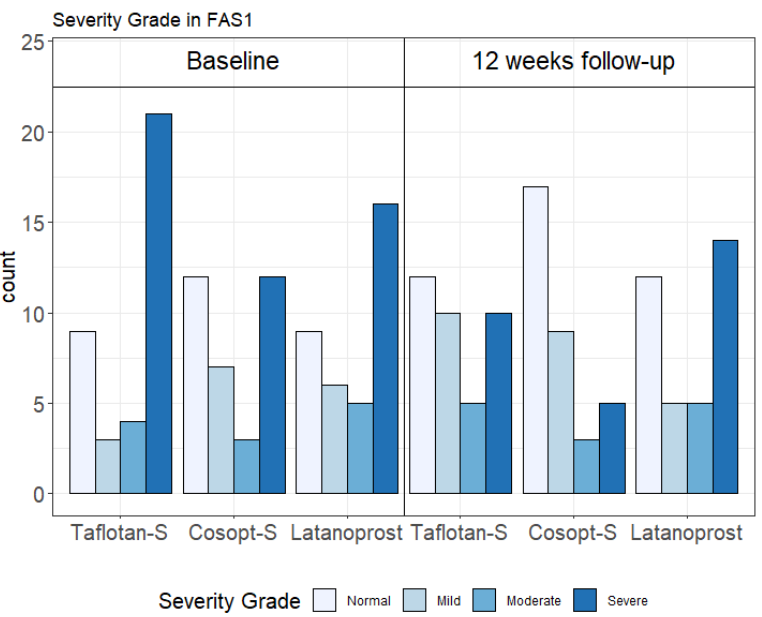
Figure 1. Ocular surface disease index (OSDI) severity categories in each treatment arm at baseline and 12-week follow-up in the Full Analysis Set 1 (FAS1) population ( n = 107). Taflotan-S = preservative-free tafluprost; Cosopt-S = preservative-free dorzolamide + timolol; Latanoprost = preservative-containing latanoprost.